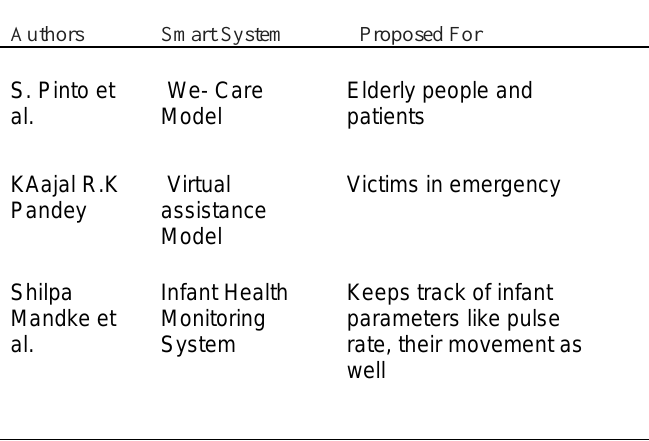
Table 1. IoT Based Models with their Impact on